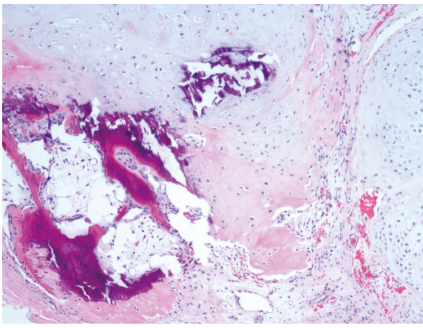
Figure 8: Microscopic image of chondrosarcoma at 20x magni fi